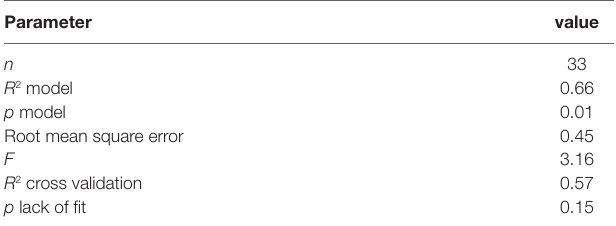
Table 3 | Statistical significance of the partial least squares regression linking the dipeptidyl peptidase IV (DPP-IV) half maximal inhibitory concentration (IC 50 ) of the peptides used to generate the quantitative structure activity relationship model.